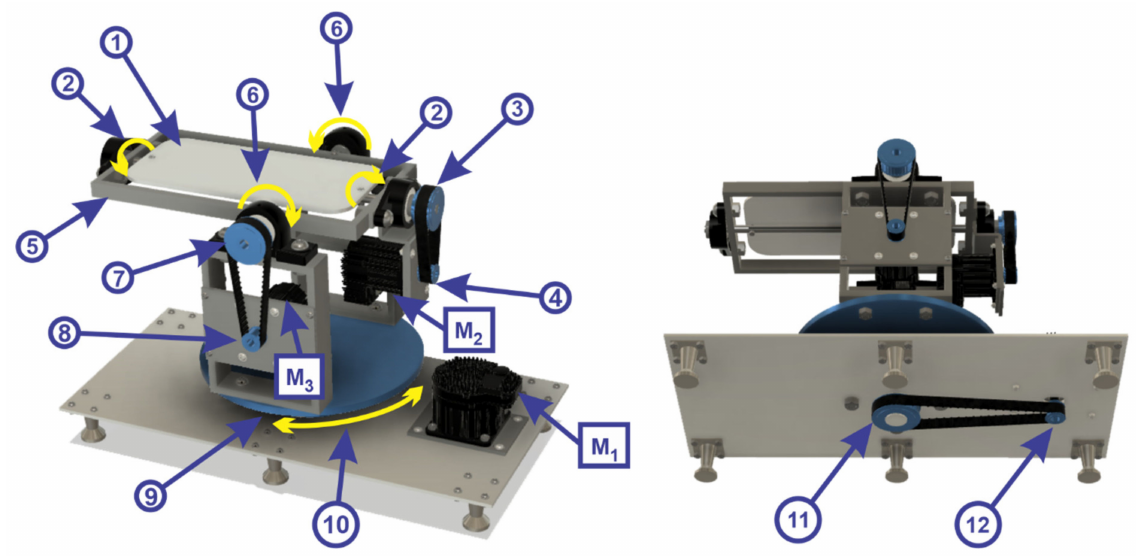
Figure 4. Robotic rehabilitation